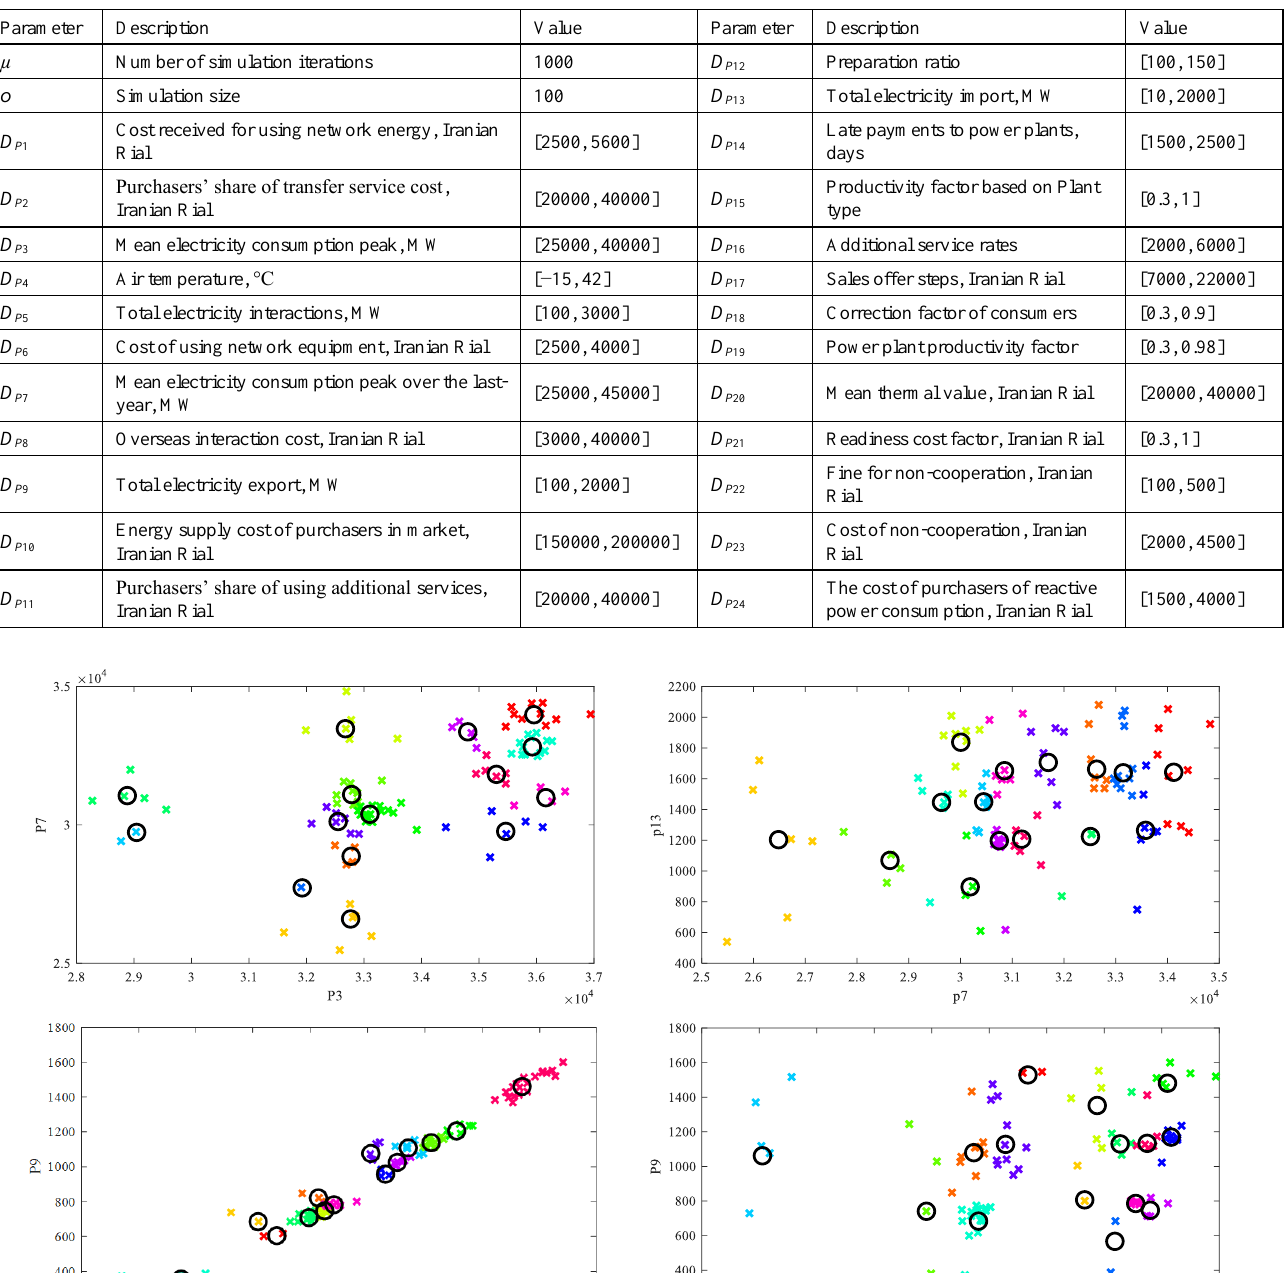
TABLE III M ONTE C ARLO S IMULATION P ARAMETERS